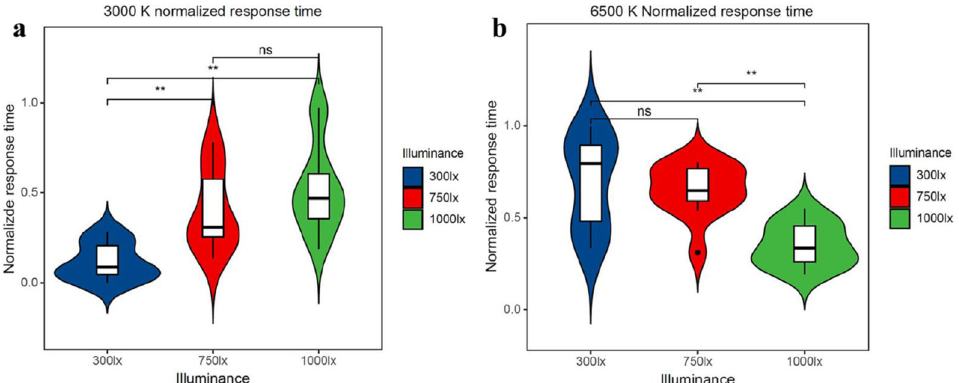
Figure 2. (a) The min–max–normalized response time of the experimental task under different illuminances at 3000 K. (b) The min–max–normalized response time of the experimental task under different illuminances at 6500 K. The upper diagram shows that the response times of 3000–300 lx and 6500–1000 lx were significantly lower than others (*P < 0.05; **P < 0.01).